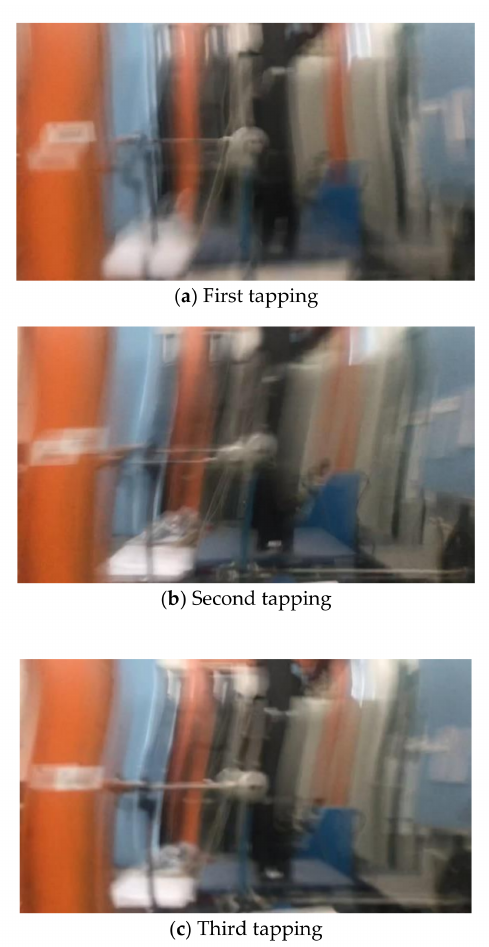
Figure 12. Blurred images after each tapping.